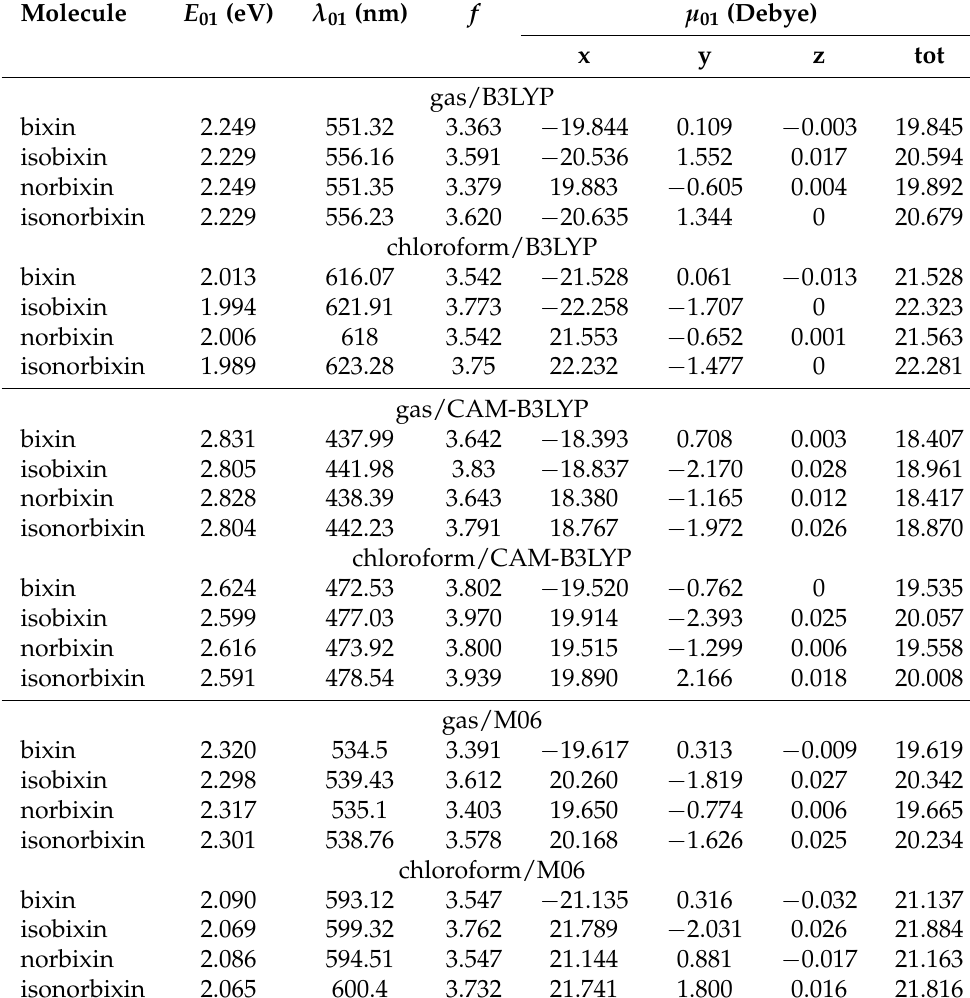
Table 4. S 0 → S 1 vertical transition energies ( E 01 ), wavelength ( λ 01 ), oscillator strength ( f ), and tran- sition dipole moments ( µ 01 ). These results were obtained by employing the 6-31+G(d,p) basis set. Molecule E 01